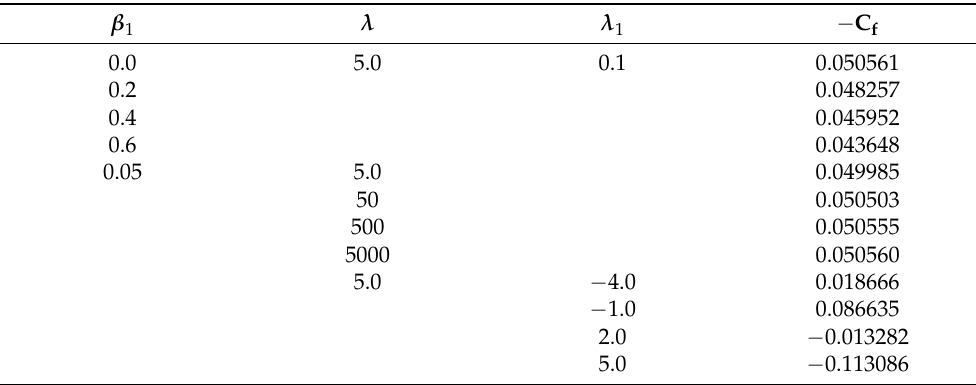
Table 3. The results for the skin friction coefficient of Al 2 O 3 –Ag/H 2 O against nondimensional parameters.